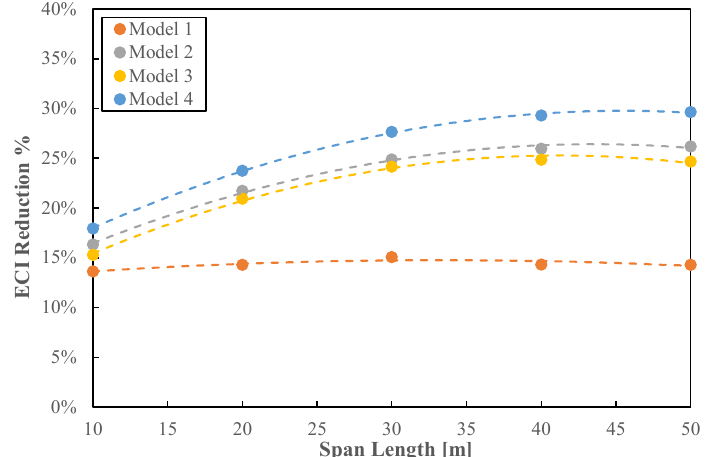
Figure 6. Average ECI reduction variation with span length for different